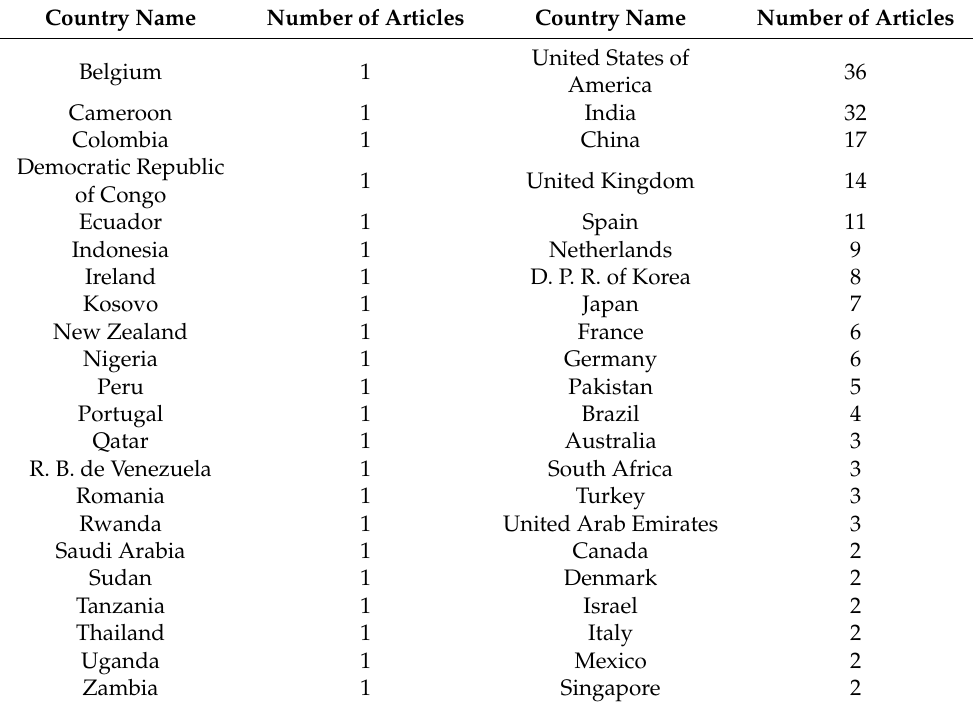
Table 1. List of countries, depicting the number of articles found during the search and grouped according to the first author’s country of